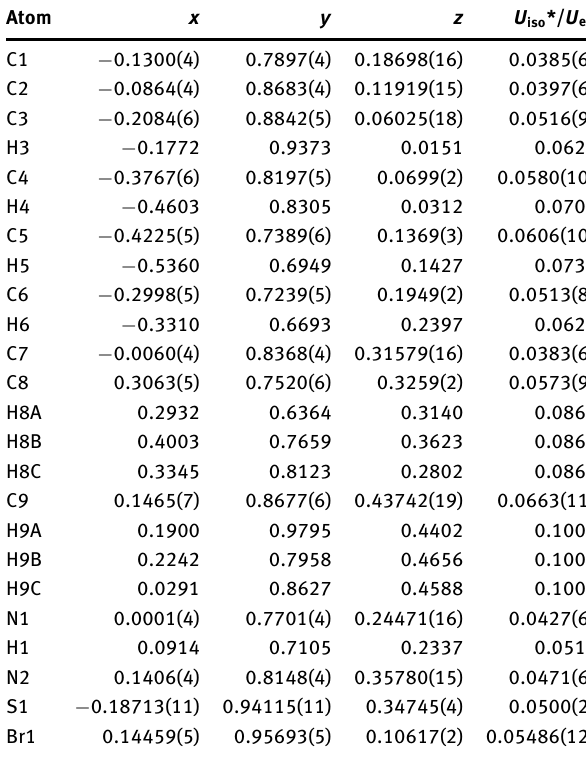
Table 2: Fractional atomic coordinates and isotropic or